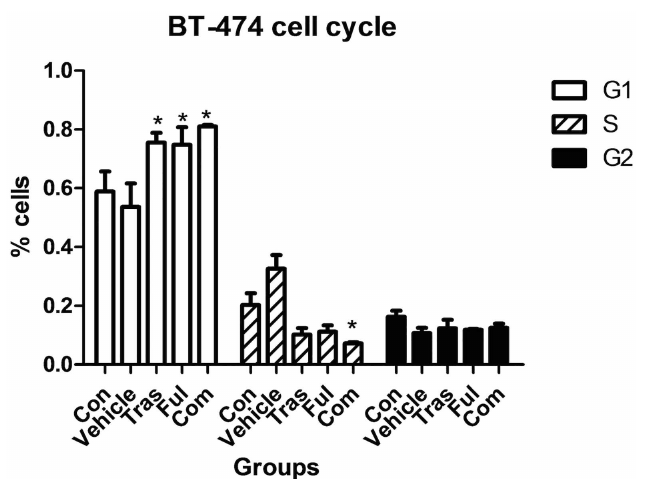
Fig 5. Effects on the cell cycle progression of BT-474 cells after continuous exposure to trastuzumab and fulvestrant as single agents or in combination for 72h. Trastuzumab and fulvestrant as single agents or as a combination promoted the accumulation of BT-474 cells in the G1 phase of the cell cycle. However,no statistically significantdifferences were detected betweenthe combination treatment group and individual drug-treated groups(P > 0.05). The cell cycle stage distribution of BT-474 cells in the five different groups are shown in S4 Fig of the supplementary information section. * P < 0.05compared with control